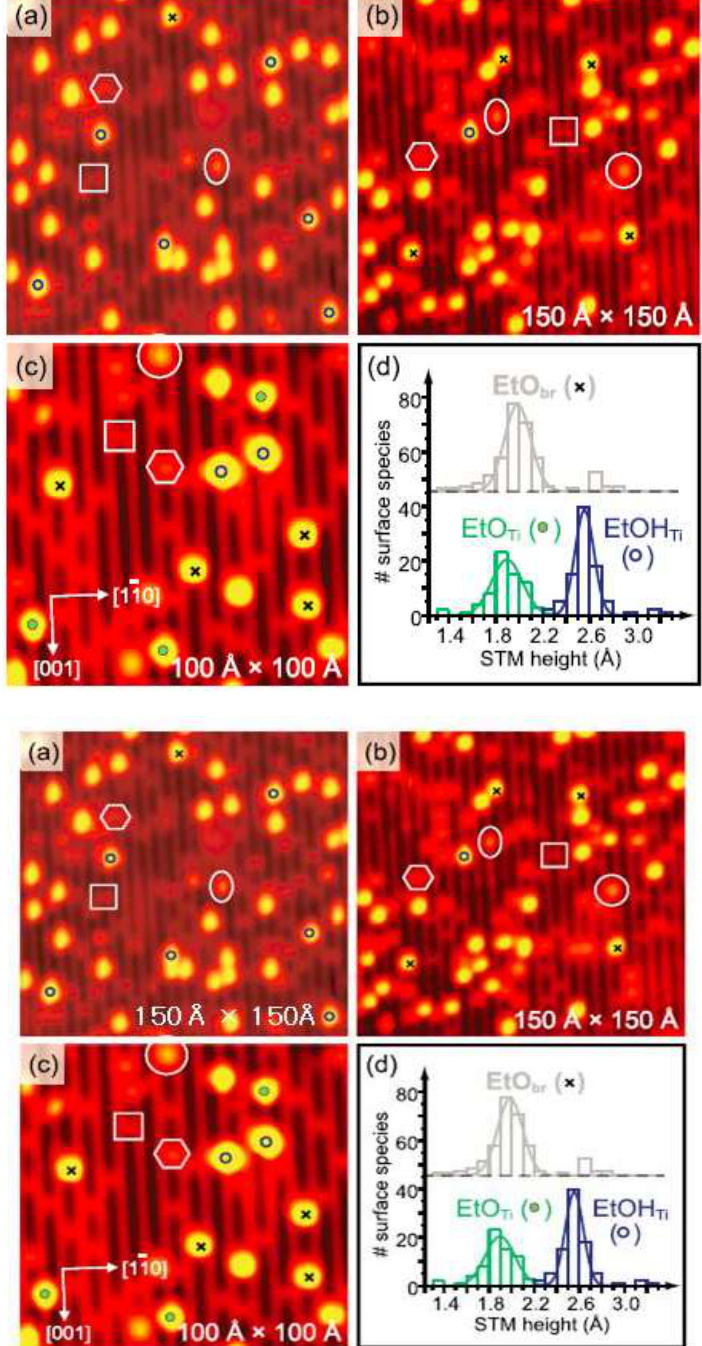
Figure 1. STM images obtained after EtOH exposure onto TiO 2 (110): ( a – c ) EtO br are indicated by a black cross, EtO Ti by a green solid dot, EtOH Ti by a hollow blue circle. Other symbols indicate O vac (square), H adatom (hexagon), H adatom pair (square), and water (ellipse), respectively. ( d ) STM height histograms of the three adsorbates (Reprinted figure with permission from [35] Copyright (2011) by the American Physical